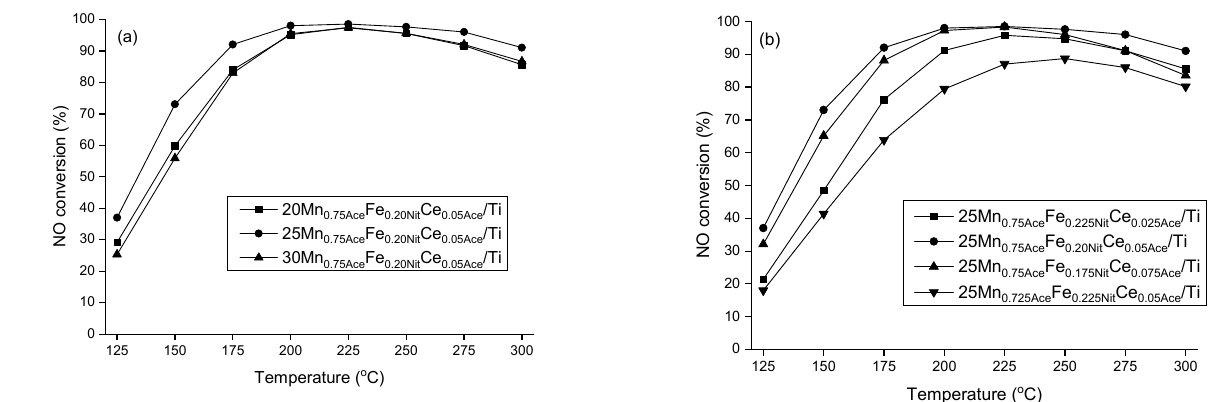
Figure 3. NO conversion profiles of: ( a ) 20–30 wt.% Mn 0.75Ace Fe 0.20Nit Ce 0.05Ace /Ti catalysts; ( b ) 25Mn Ace Fe Nit Ce Ace /Ti catalysts with Mn 0.75–0.725 , Fe 0.225–0.175 , Ce 0.075–0.025 mole fractions.